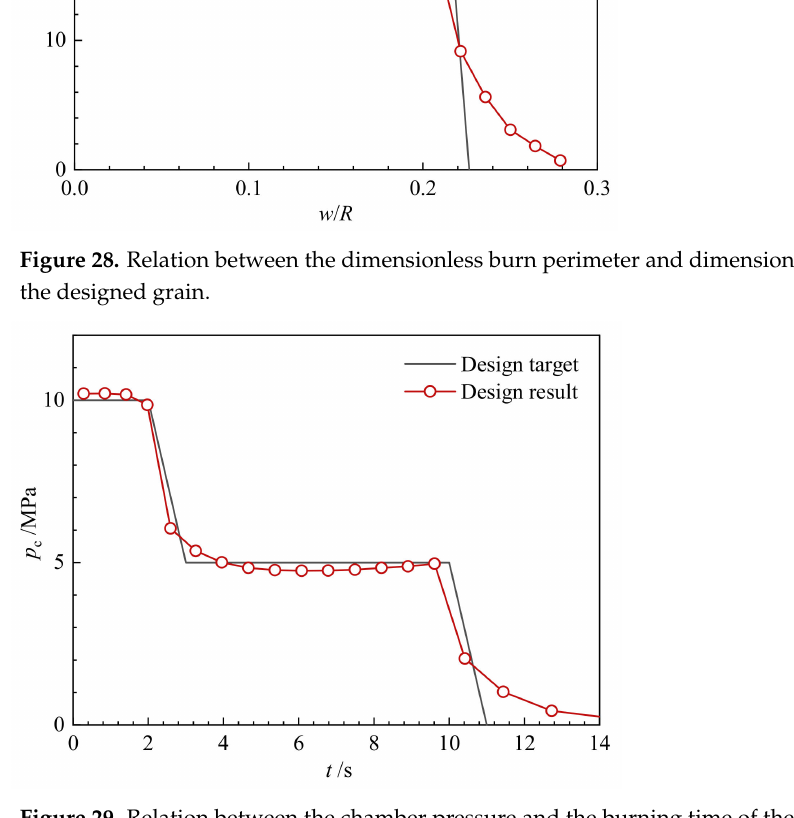
Figure 29. Relation between the chamber pressure and the burning time of the designed